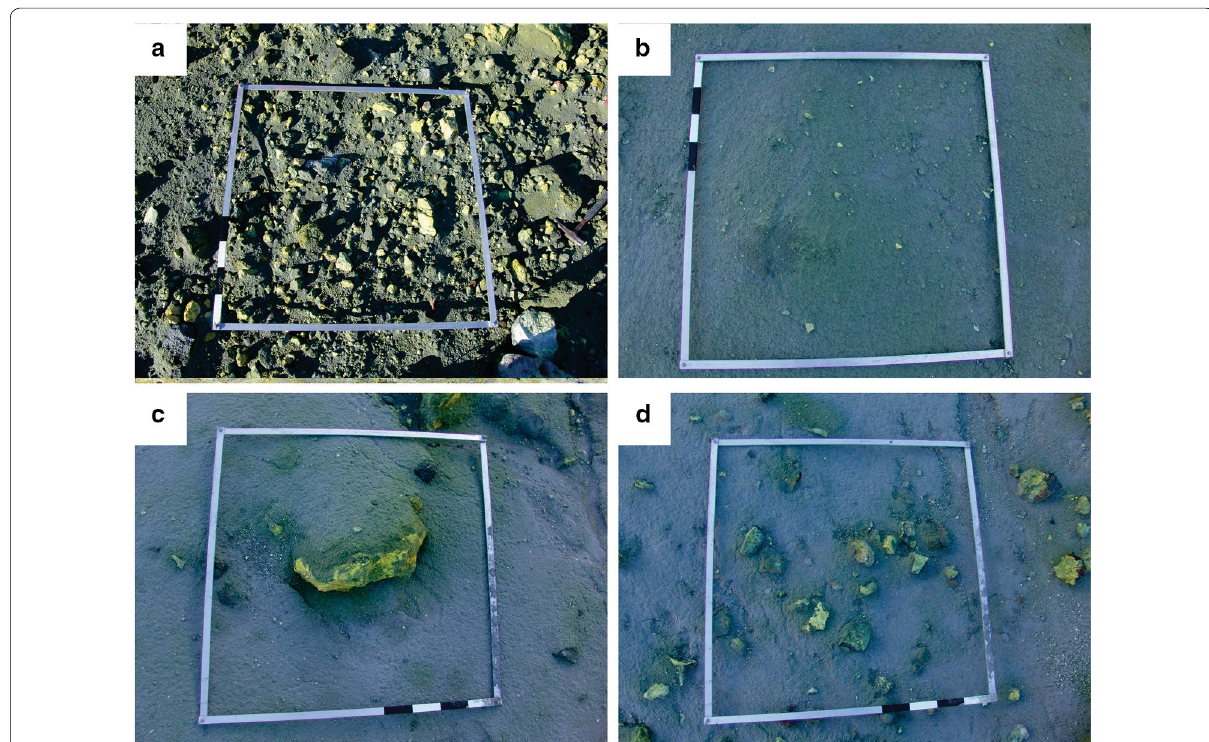
Fig. 9 The use of an aluminium picture frame that is 1 m 2 provides a rapid reconnaissance tool for collecting highly variable ballistic ejecta images with limited exposure